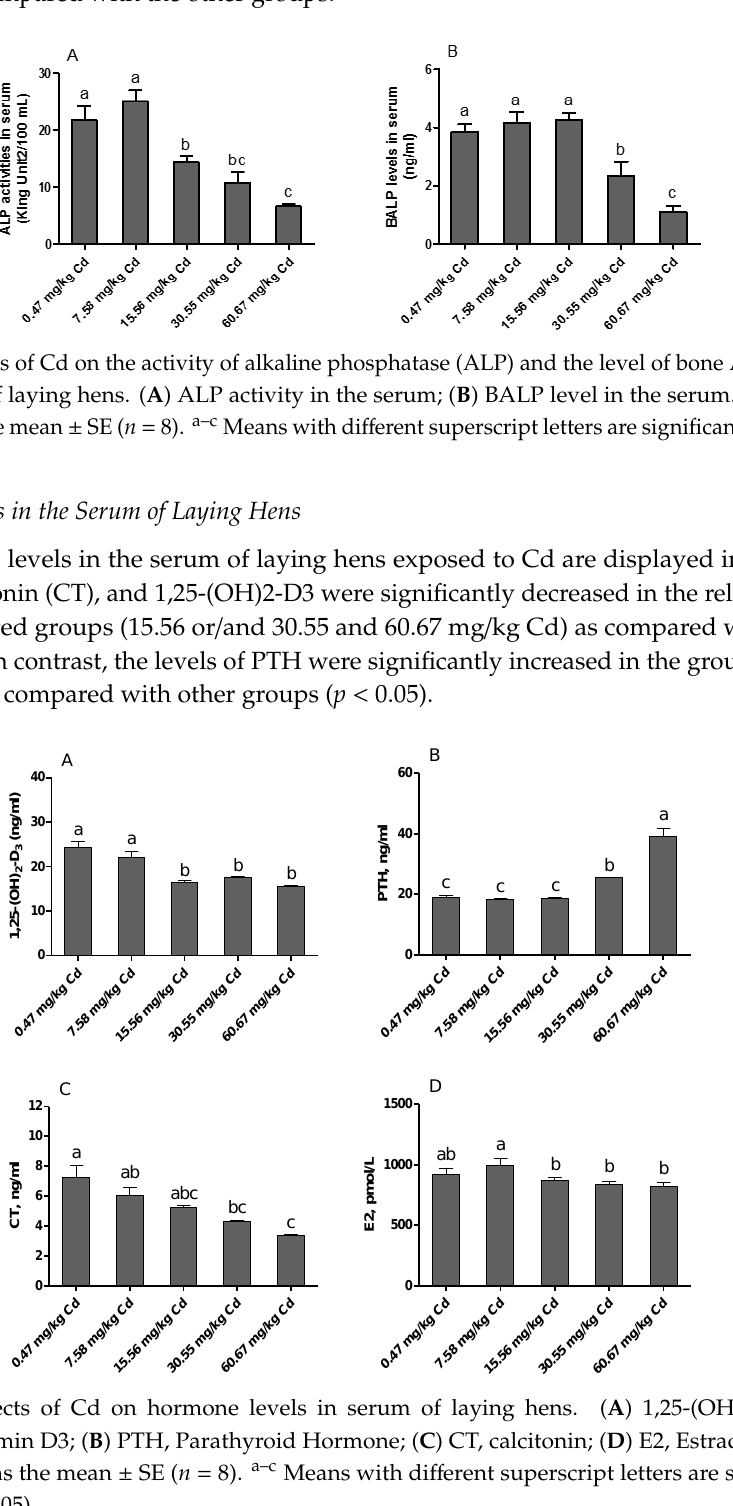
Figure 1. Effects of Cd on Cd, Ca and P levels in the serum and kidney of laying hens. ( A ) serum Cd level; ( B ) Cd level in the kidney; ( C ) serum Ca level; ( D ) serum P level. Values are presented as the mean ± SE ( n = 8). a–e Means with different superscript letters are significantly different ( p < 0.05).